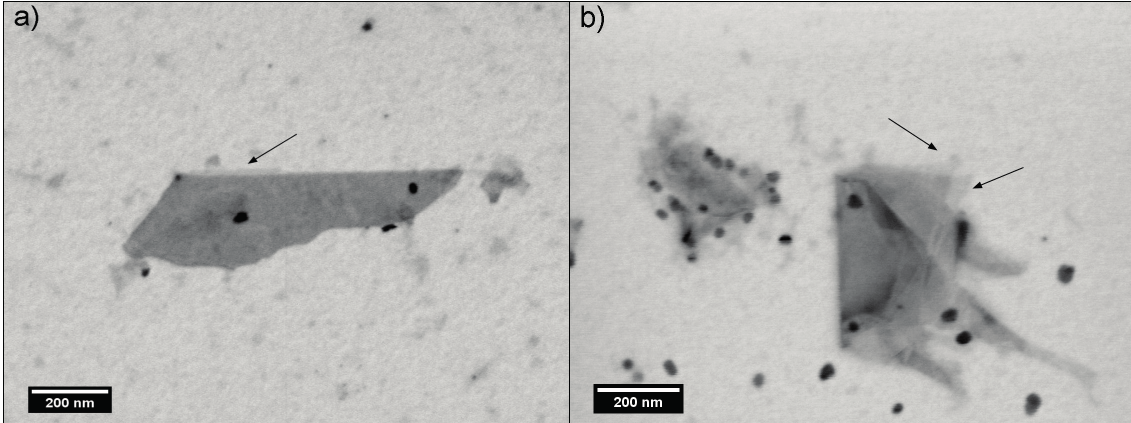
Figure 6. Scanning transmission electron microscopy (STEM) images of FLG/porphyrin hybrids: ( a ) FLG/DMPP and ( b ) FLG/ZnDMPP. The areas marked with arrows correspond to single-layer